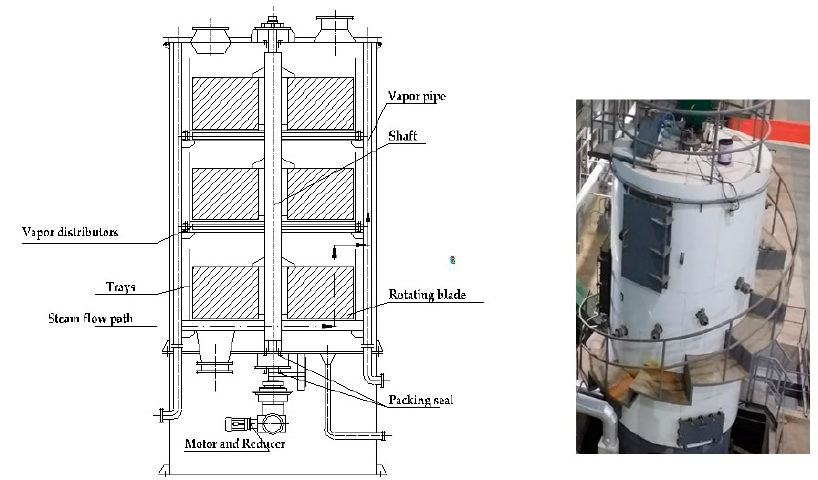
Figure 8. Structure of continuous solid-state distillation (CSSD) column.